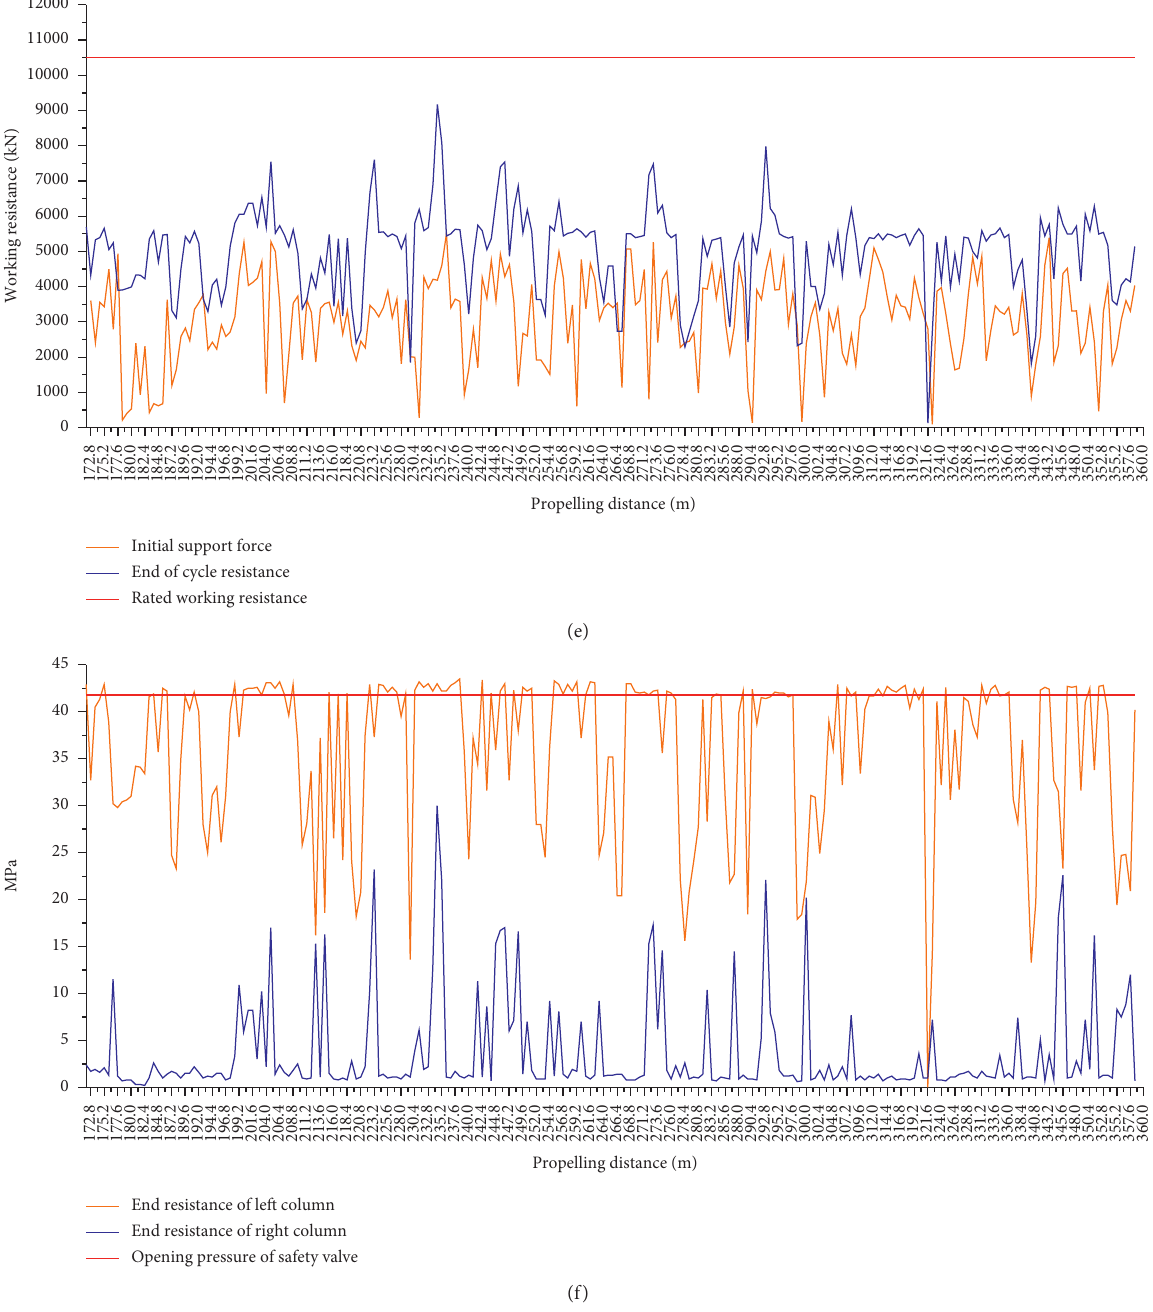
Figure 5: Circulation curve of working resistance of support and single column. (a) Circulation curve of working resistance of 49# support. (b) Circulation curve of working resistance of a single column of 49# support. (c) Circulation curve of working resistance of 64# support. (d) Circulation curve of working resistance of a single column of 64# support. (e) Circulation curve of working resistance of 118# support. (f) Circulation curve of working resistance of a single column of 118#